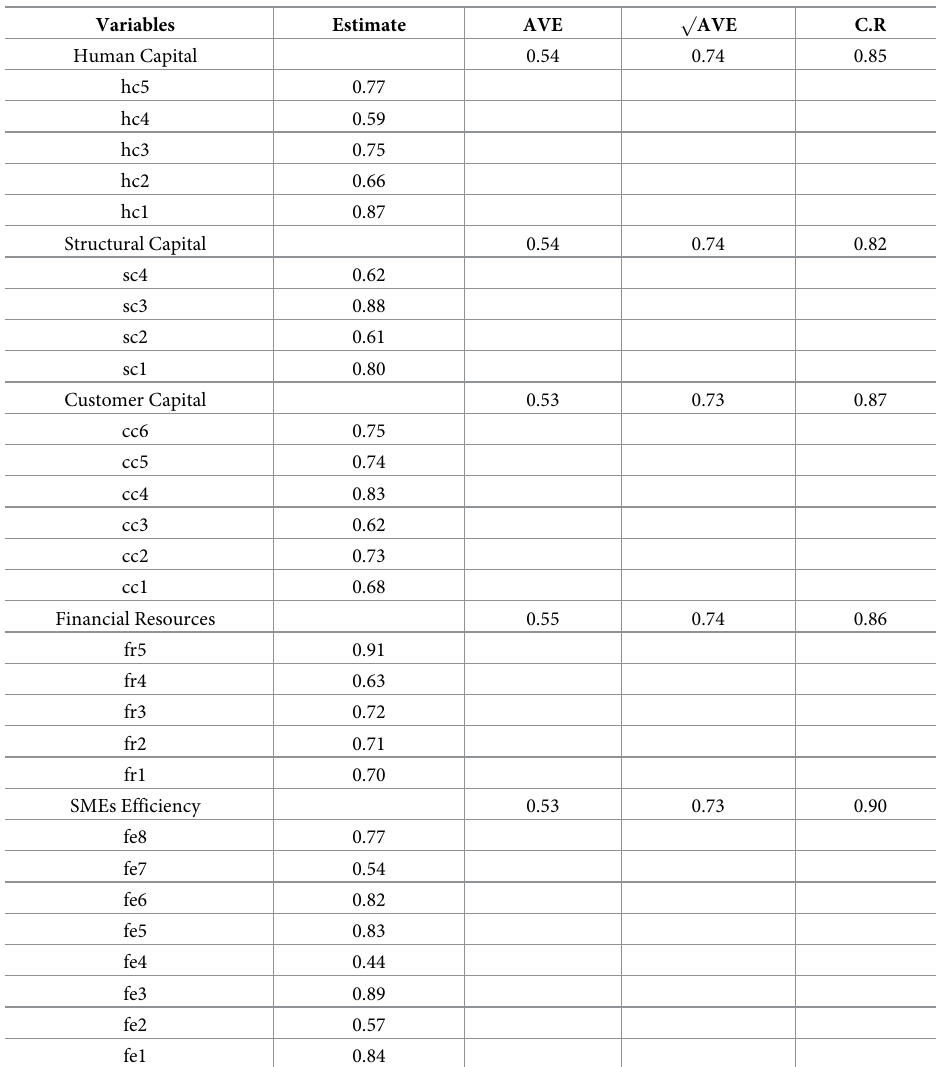
Table 4. Validity and